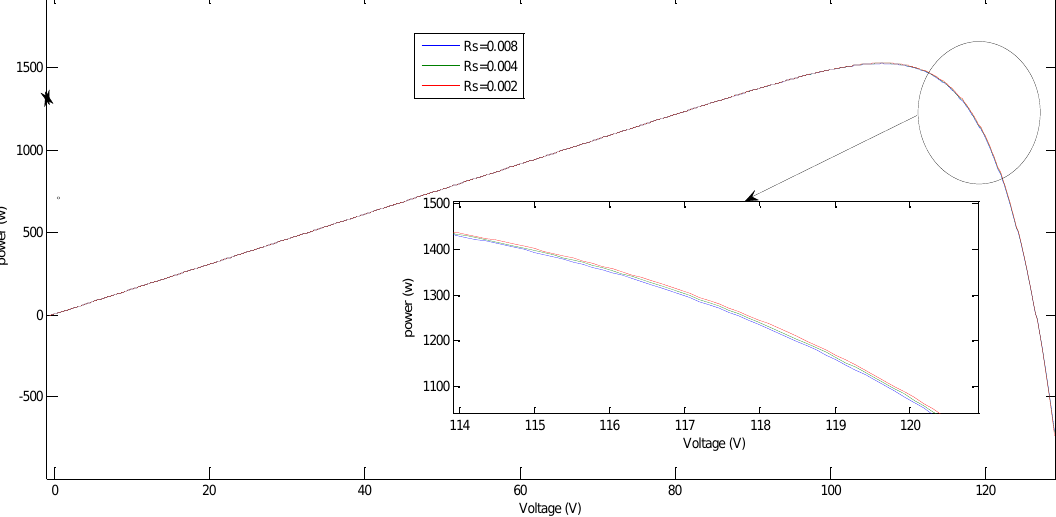
Figure 7. Effect of variation of PV cell series resistance on the power output of PV array.